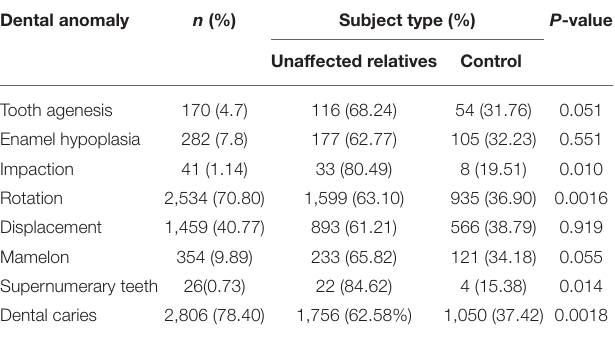
TABLE 3 | Distribution of dental anomalies by subject